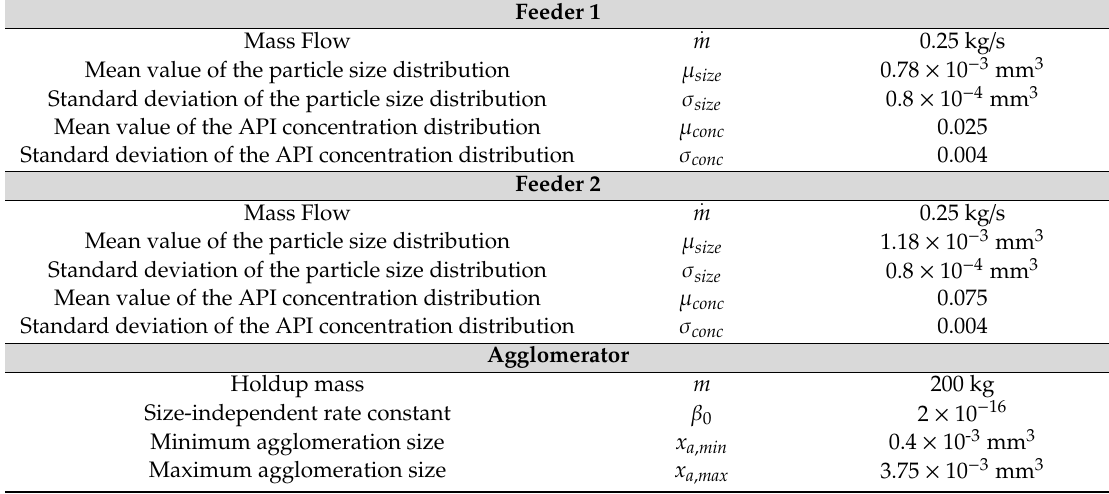
Table 1. Model parameters used for the agglomeration